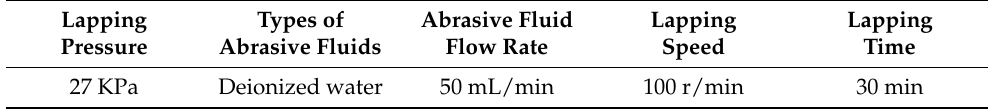
Table 2. Lapping experimental process parameters.